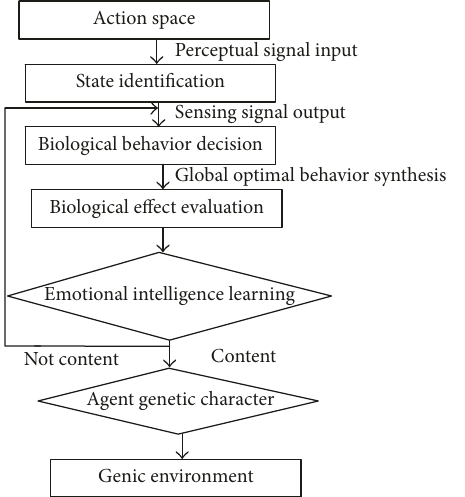
Figure 3: Architecture of population for the proliferation of evolu- tion